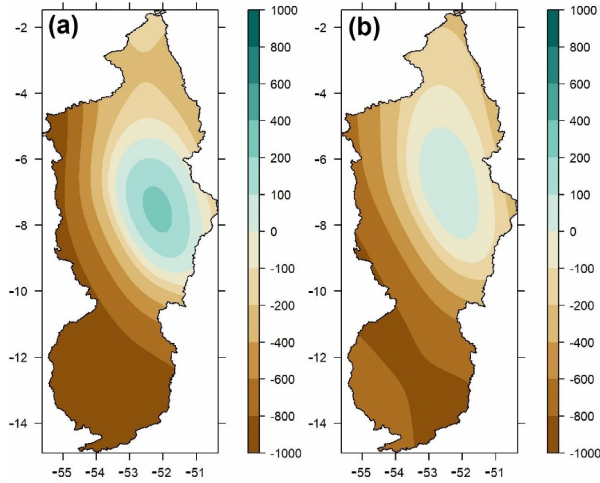
Figure 9. The same as in Figure 7, but for the 2051–2080